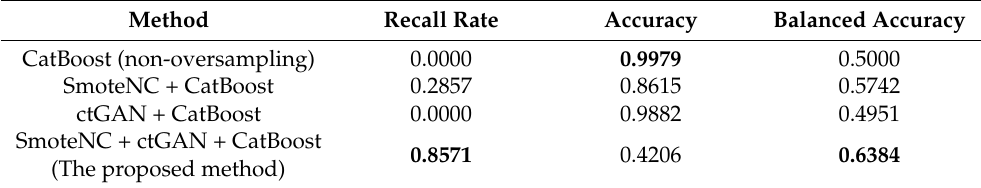
Table 16. Prediction results obtained for the RNF diagnosis using other methods used for processing limited